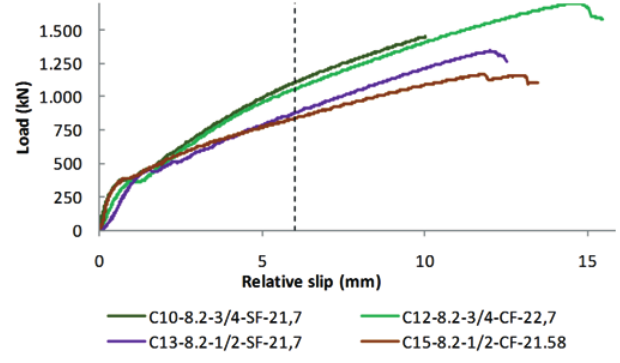
Figure 15 Curves load versus relative displacement - influence of the hole dimension for the C8 and C9